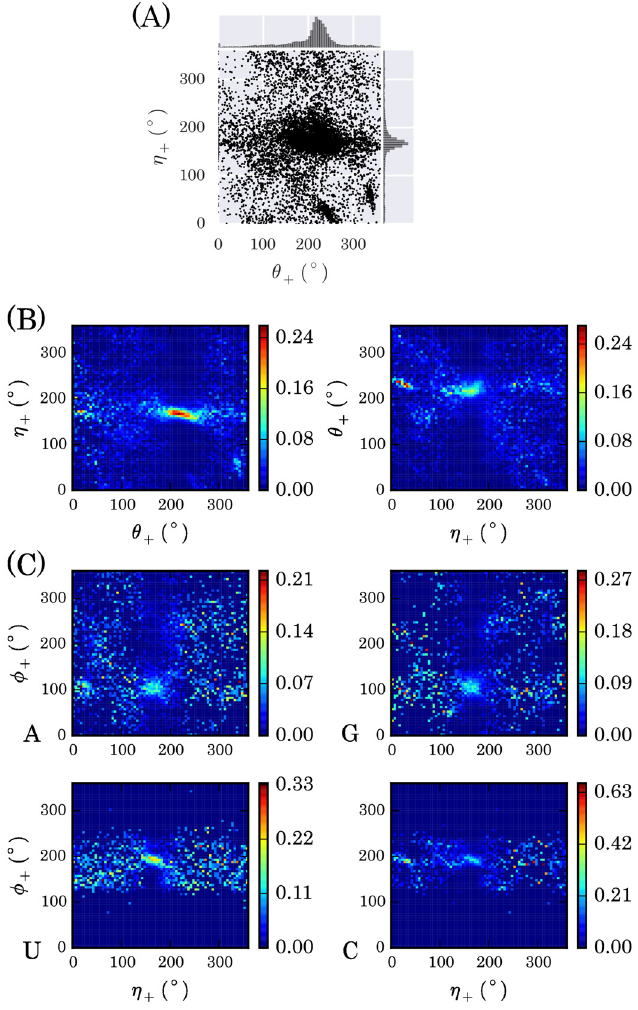
Fig 4. Conditional probabilities between different pairs of torsional angles. (A) Distribution of the raw data of the consecutive θ + and η + torsional angles in loops obtained from RNA09 database. (B) The conditional probability distribution of p ( η + | θ + ) and p ( θ + | η + ). (C) The conditional probability distribution of p ( ϕ + | η + ). Note that the distributions are dependent on the type of the nucleotides, while in such dependence is ignored approximately. See the discussion in the